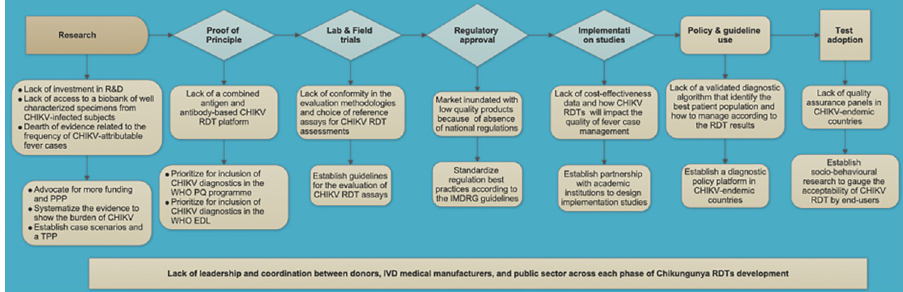
Fig 4. CHIKV RDTs: Fragmented landscape presents market challenges and opportunities for interventions. CHIKV, Chikungunya; RDT, rapid diagnostic test; WHO, World Health Organization.